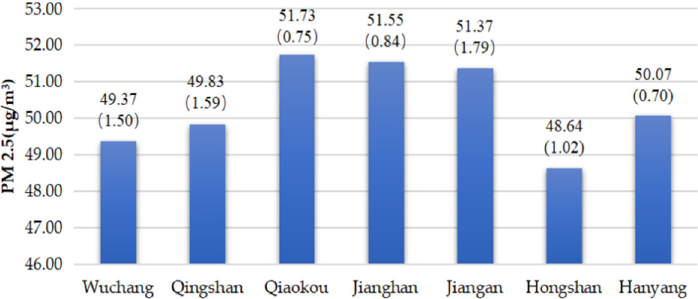
Figure 6. PM 2.5 values of different districts.